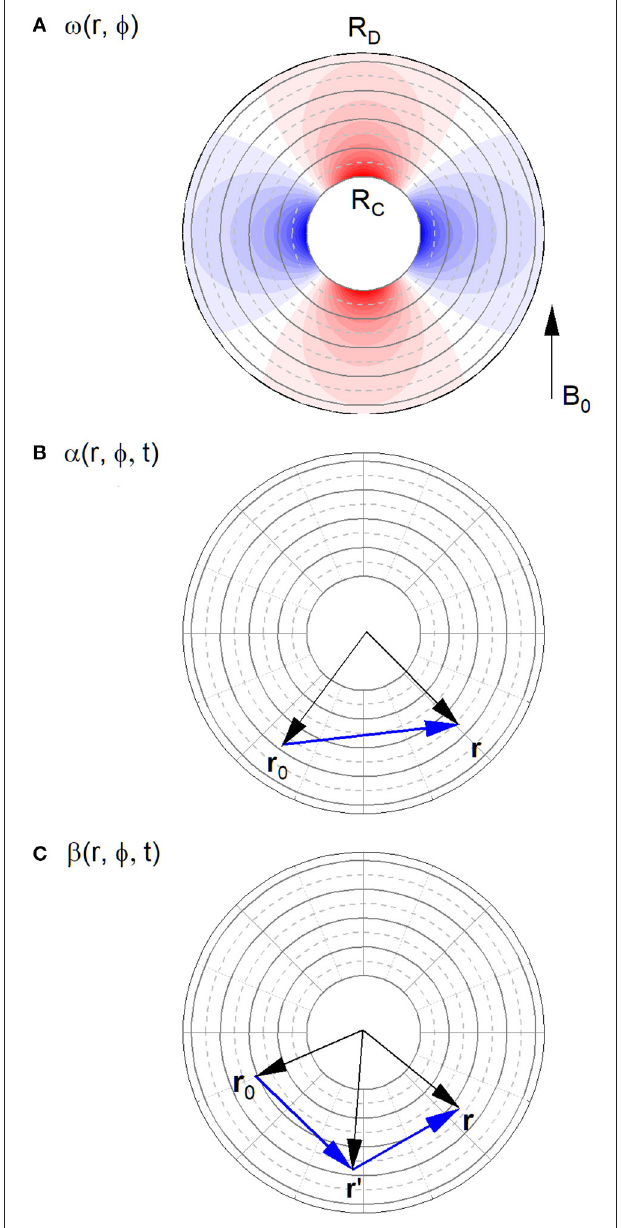
FIGURE 1 | Larmor frequency and phase distribution moments. (A) Larmor frequency in the dephasing domain. The red and blue regions correspond to positive and negative values of ω ( r , φ ). The external magnetic field B 0 is indicated by a black arrow. (B) First moment of the phase distribution, corresponding to taking into account one previous location. (C) Second moment of the phase distribution, corresponding to taking into account two previous